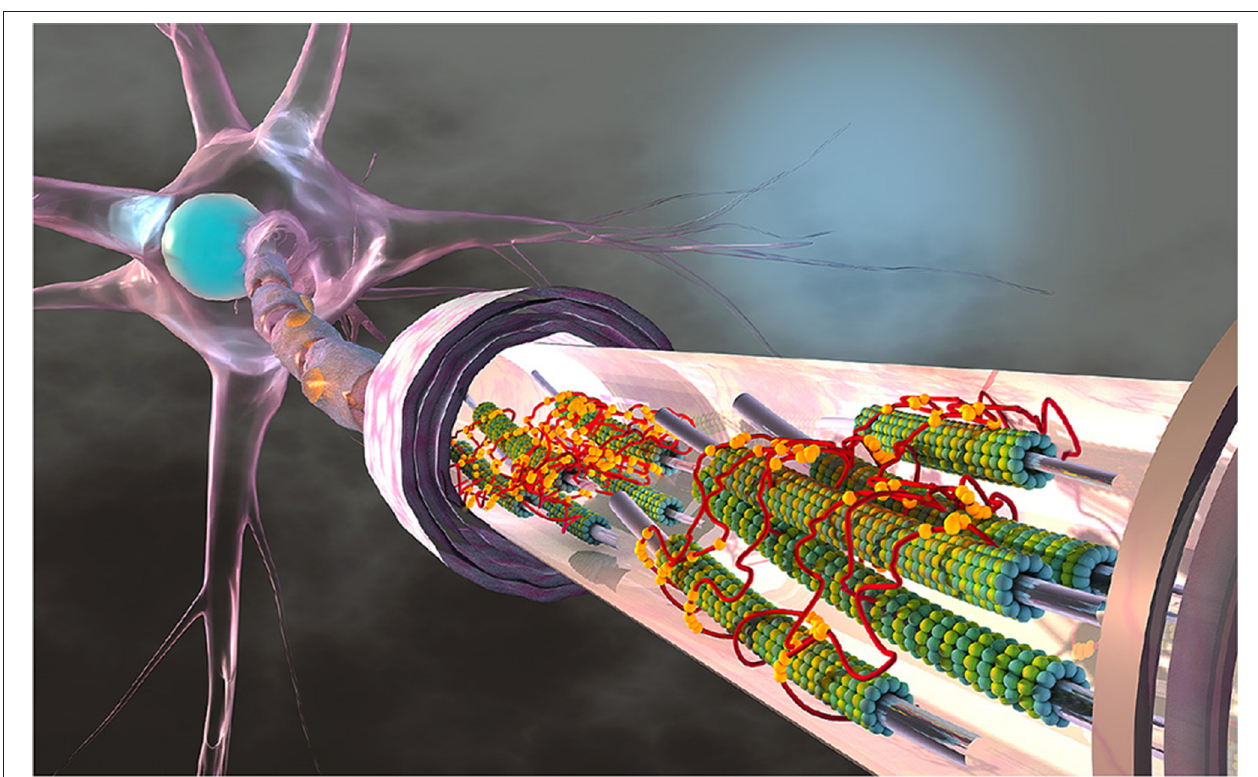
FIGURE 1 | The axon is a long and slender protrusion from the neuronal cell body that consists of a system of longitudinally aligned microtubules. Microtubules are composed of heterodimers of α - and β -tubulin, shown in green and blue, that form 13 laterally joined protofilaments, each up to 100 µ m long. Axons can extend several centimeters in length and their microtubules never run continuously from the cell body to the distal end. Instead, they form overlapping segments with 10–50 microtubules in any given cross section. Neuronal microtubules are stabilized and cross-linked by tau proteins, shown in red, which bind to microtubules with their three or four binding repeats, shown in yellow. Several components of the axon including neurofilaments, other crosslinking proteins, and cytoskeletal organelles are not